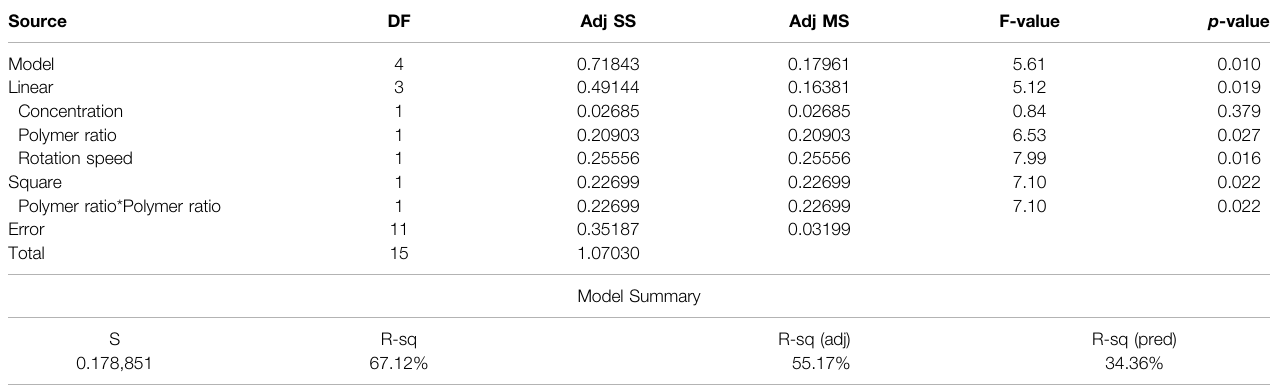
TABLE 5 | Analysis of variance for stress.